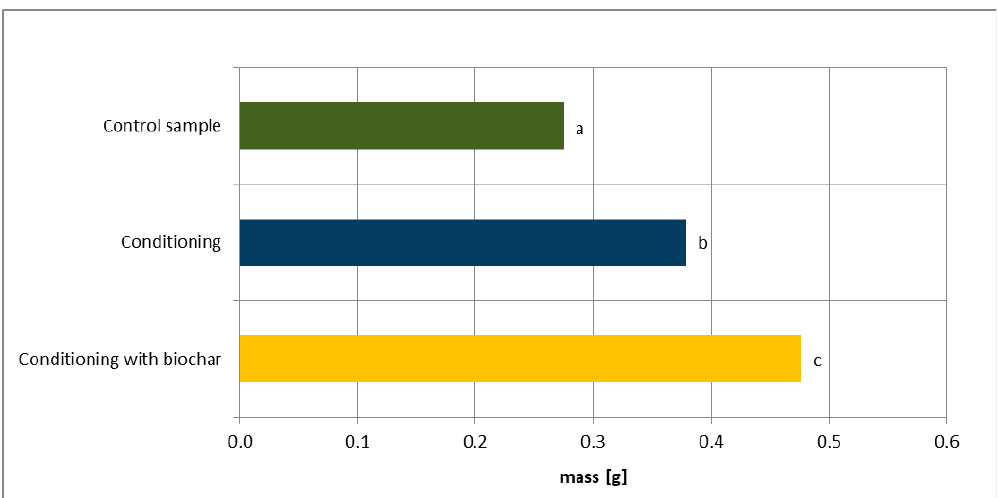
Figure 2. The total masses of Virginia mallow seedlings in the experimental variants. According to Duncan’s test, means marked with the same letter are not significantly different at α ≤ 0.05.